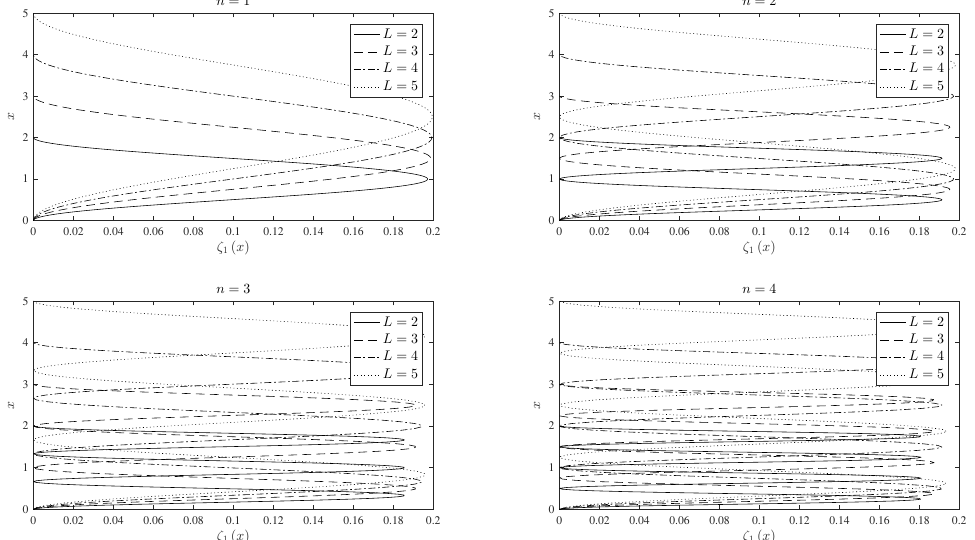
Figure 12. Different mode shapes of the buckled elastic clamped beam for the four lowest buckling forces, n = 1, . . . ,4, as functions of the length L of the beam. The indeterminate constant is set as b =